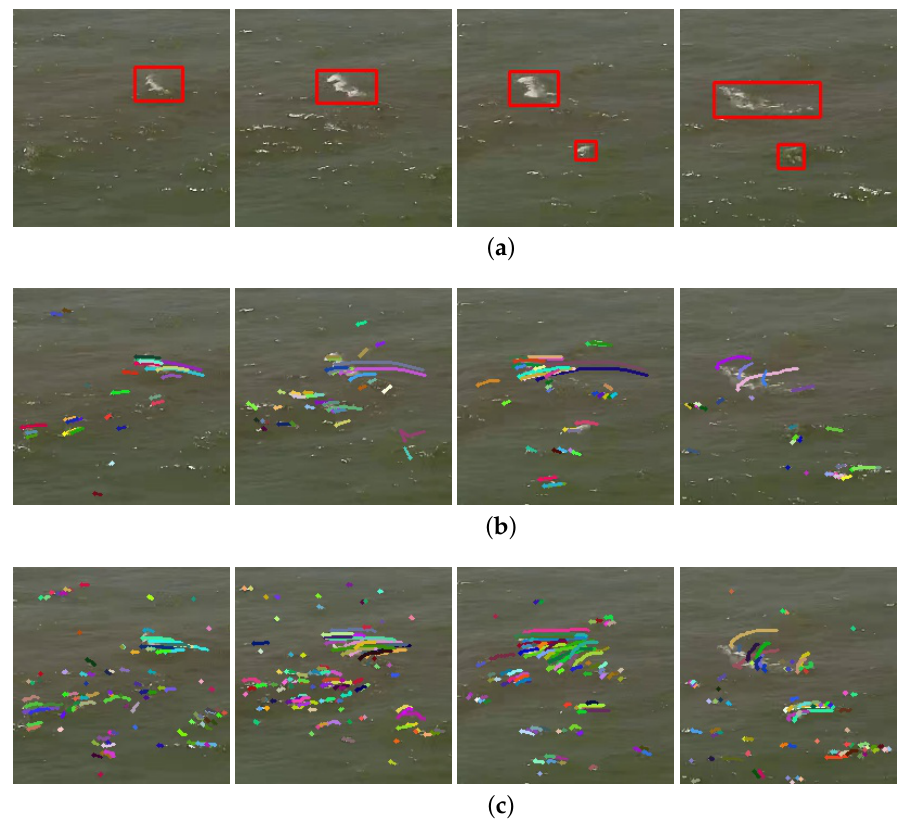
Figure 8. ( a ) Original video. ( b ) The corresponding optical flow trajectory at one sampling rate. The interval ∆ t between two images is 0.64 s. ( c ) The corresponding optical flow trajectory at the other sampling